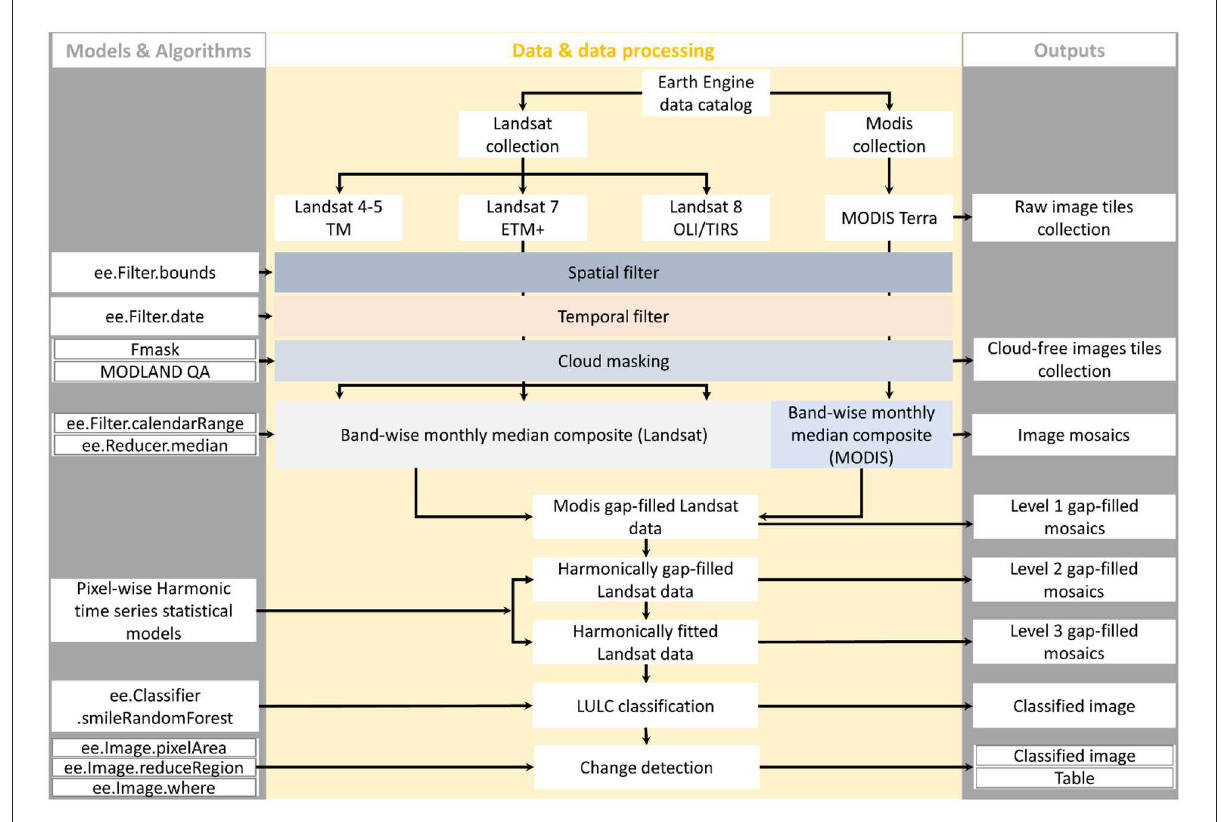
FIGURE2 Image processing routine used for a spatial analysis of mangrove vegetation of The Gambia.